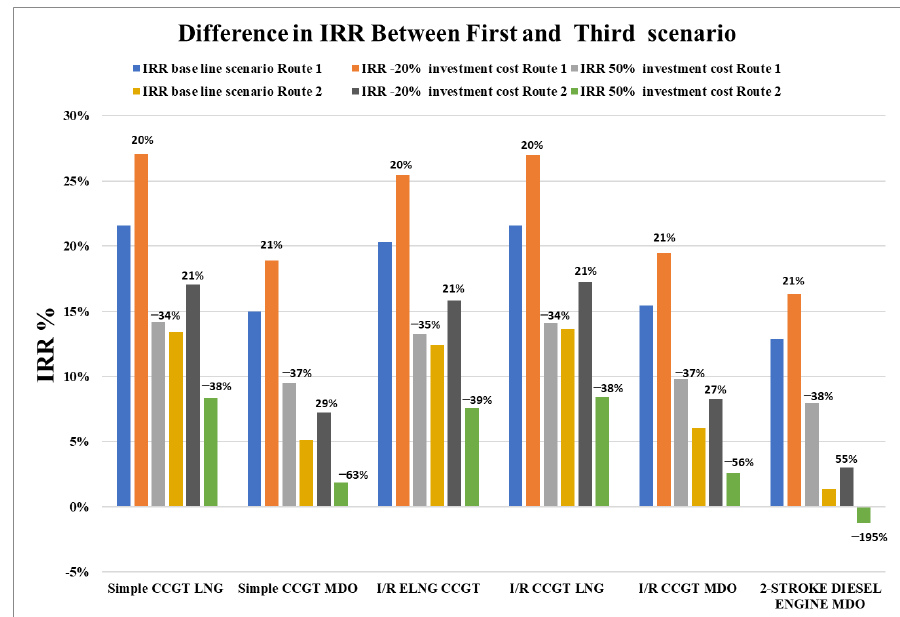
Figure 9. Difference in IRR between the first and third scenarios for Routes 1 and 2.